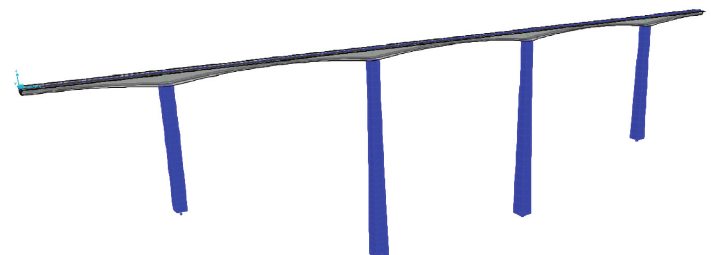
Figure 4: Finite element model.